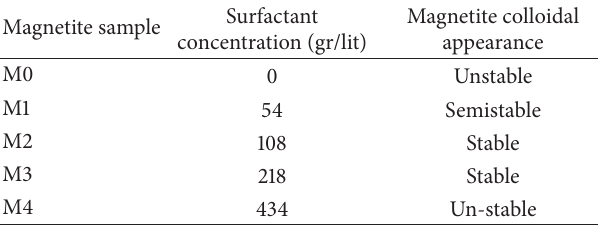
O particlessynthesize 3 4 O particles. 3 4